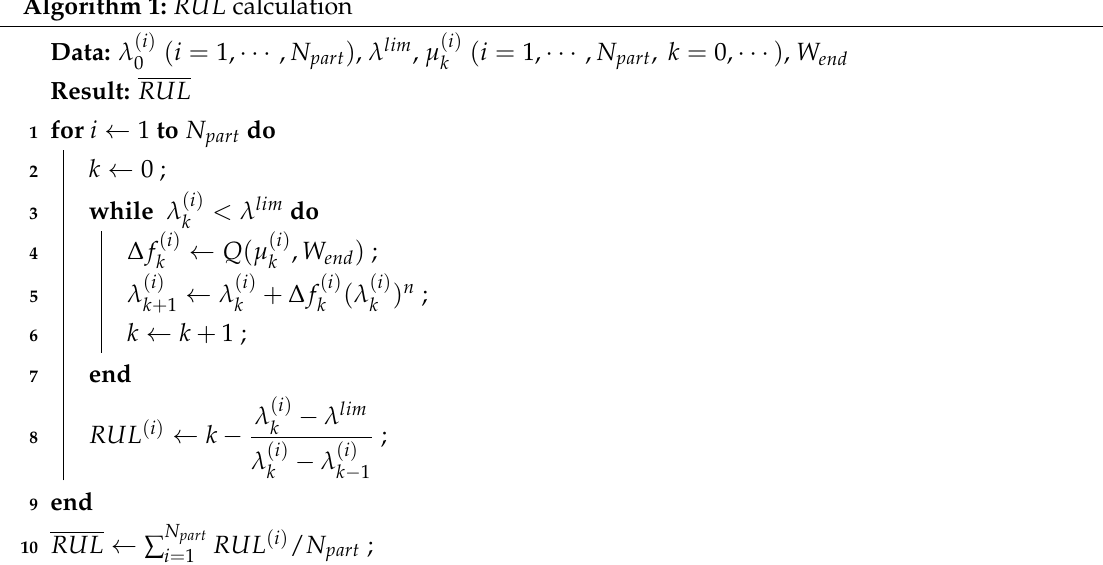
Algorithm 1: RUL